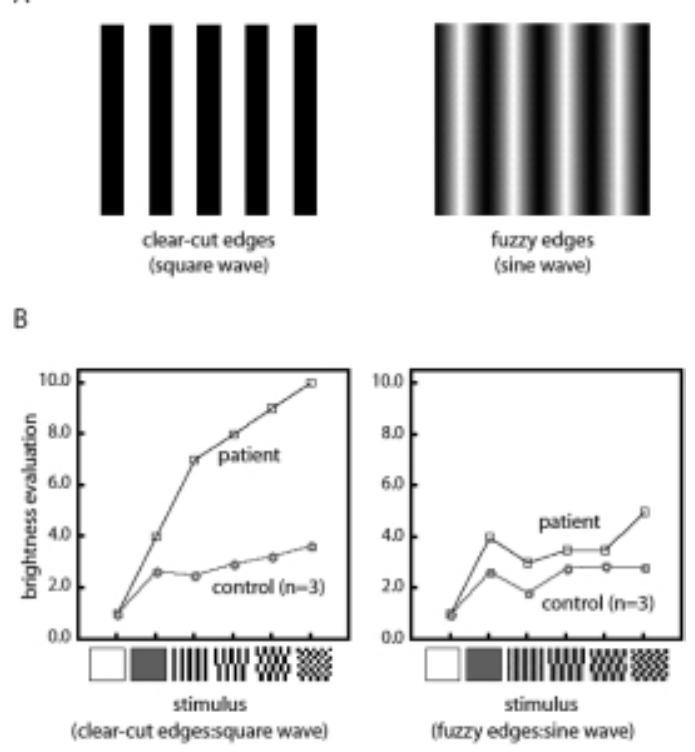
Fig. 2. (A) The stimuli used in the photosensitivity test. Note that the edges are clear-cut in the square-wave stimulus whereas the edges are fuzzy in the sine-wave stimulus. (B) Brightness perception of stripes and grids which consisted of square waves (left) and sine waves (right). The patient was very sensitive to the stripes and grids with clear-cut edges (left) whereas her brightness evaluation was similar to that of normal control in the stripes and grids with fuzzy edges